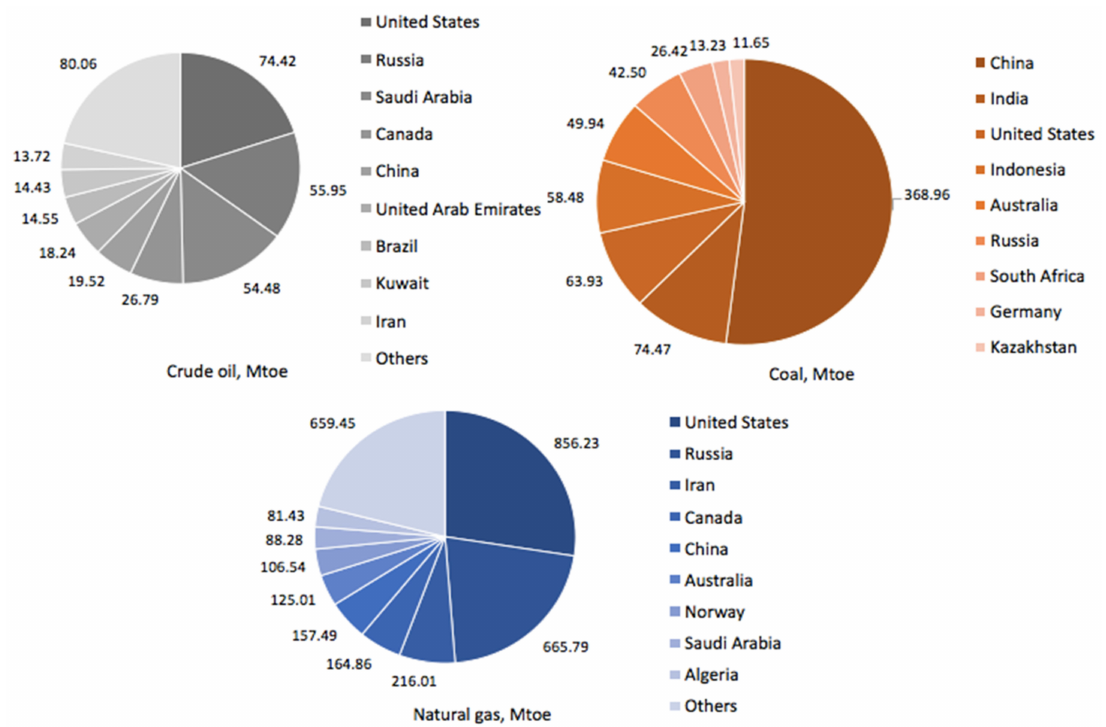
Figure 2. The leading countries in primary energy production for 2019. Crude oil: the chart shows the top nine countries and another 21 countries from the top 30 leaders combined into “others”: Nigeria, Mexico, Kazakhstan, Norway, Algeria, Venezuela, United Kingdom, Colombia, Indonesia, India, Egypt, Argentina, Malaysia, Thailand, Australia, South Africa, Germany, Ukraine, Uzbekistan, Poland, Netherlands. Coal: the chart shows the top nine countries. Natural gas: the chart shows the top nine countries and another 21 countries in the top 30 leaders grouped into “others”: Egypt, Malaysia, Indonesia, United Arab Emirates, Uzbekistan, Argentina, Kazakhstan, Nigeria, United Kingdom, Netherlands, India, Thailand, Brazil, Mexico, Ukraine, Kuwait, Venezuela, Colombia, Germany, Poland, South Africa. All countries are presented according to their rank in descending order of production [13,14].